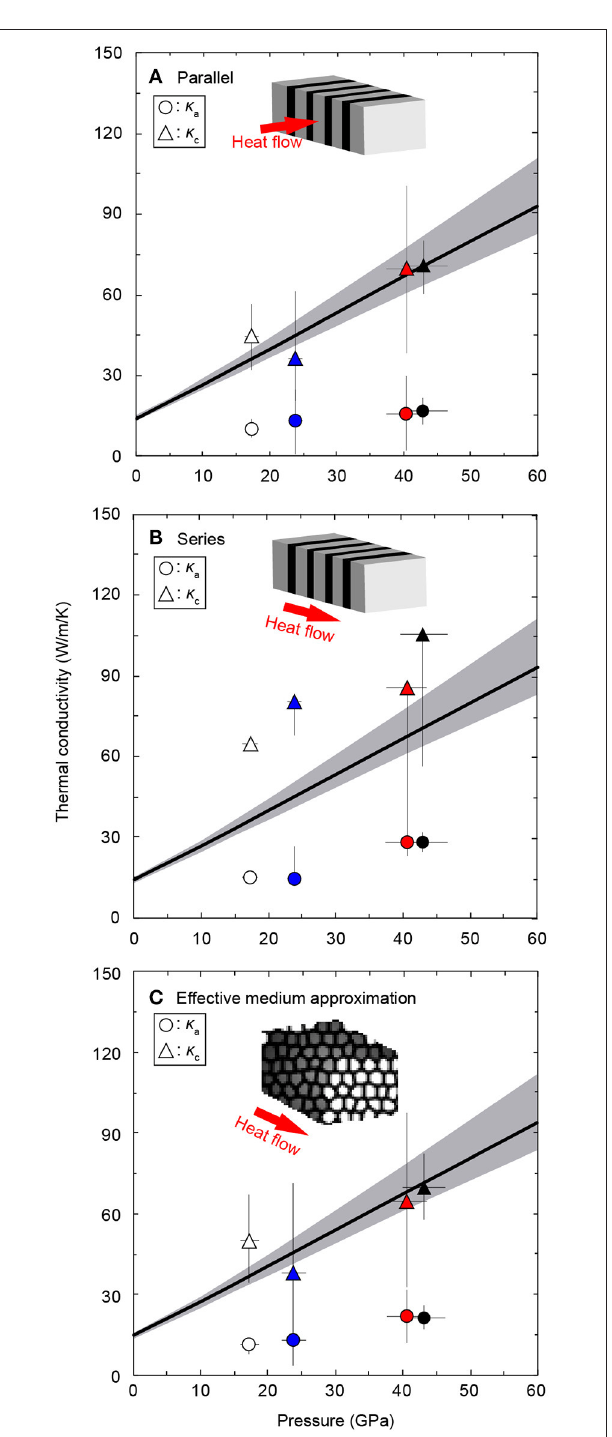
FIGURE 11 | Thermal conductivities of single crystal hcp iron along a and c axes ( κ a and κ c ) as a function of P at 300K. (A) Solutions of the parallel model (Equation 5). (B) The series model solutions (Equation 6). (C) Random distribution model calculated by the effective medium approximation (Equation 7) (Landauer, 1952). Circles; κ a , triangles; κ c . Black line with gray band is κ el of hcp iron as shown in Figure 10 . Inset figures show schematic illustrations of the parallel, series, and random models,